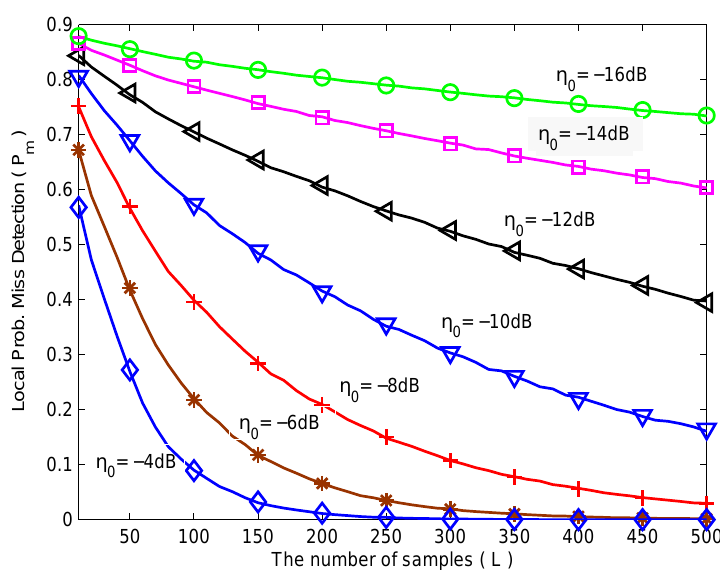
Figure 3. The local probability of miss detection as a function of the number of samples for various SNR.